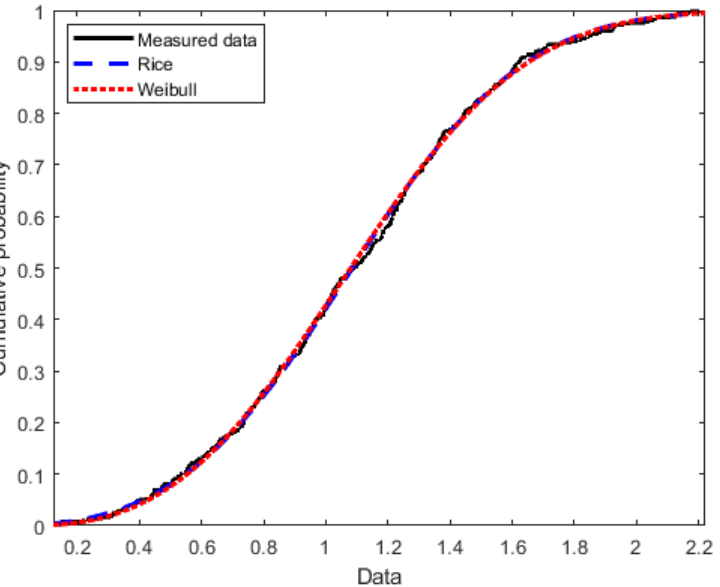
Figure 17. Cumulative distribution functions fitting fast variations within the small lab #3 at 5.8 GHz in LoS conditions.